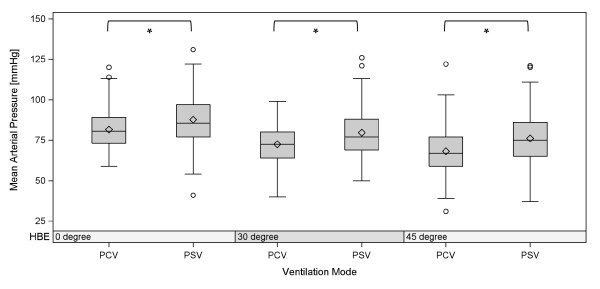
Effect of PCV vs. PSV on mean arterial pressure with significant effect in all three degrees of backrest positioning, P < 0.001. *P < 0.001: influence of ventilation mode on mean arterial pressure according to the linear mixed model. PCV: pressure controlled ventilation; PSV: pressure support ventilation.